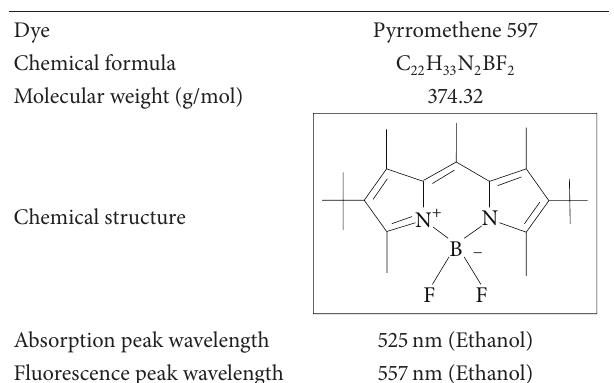
Table 1: Basic information of Pyrromethene 597 dye taken